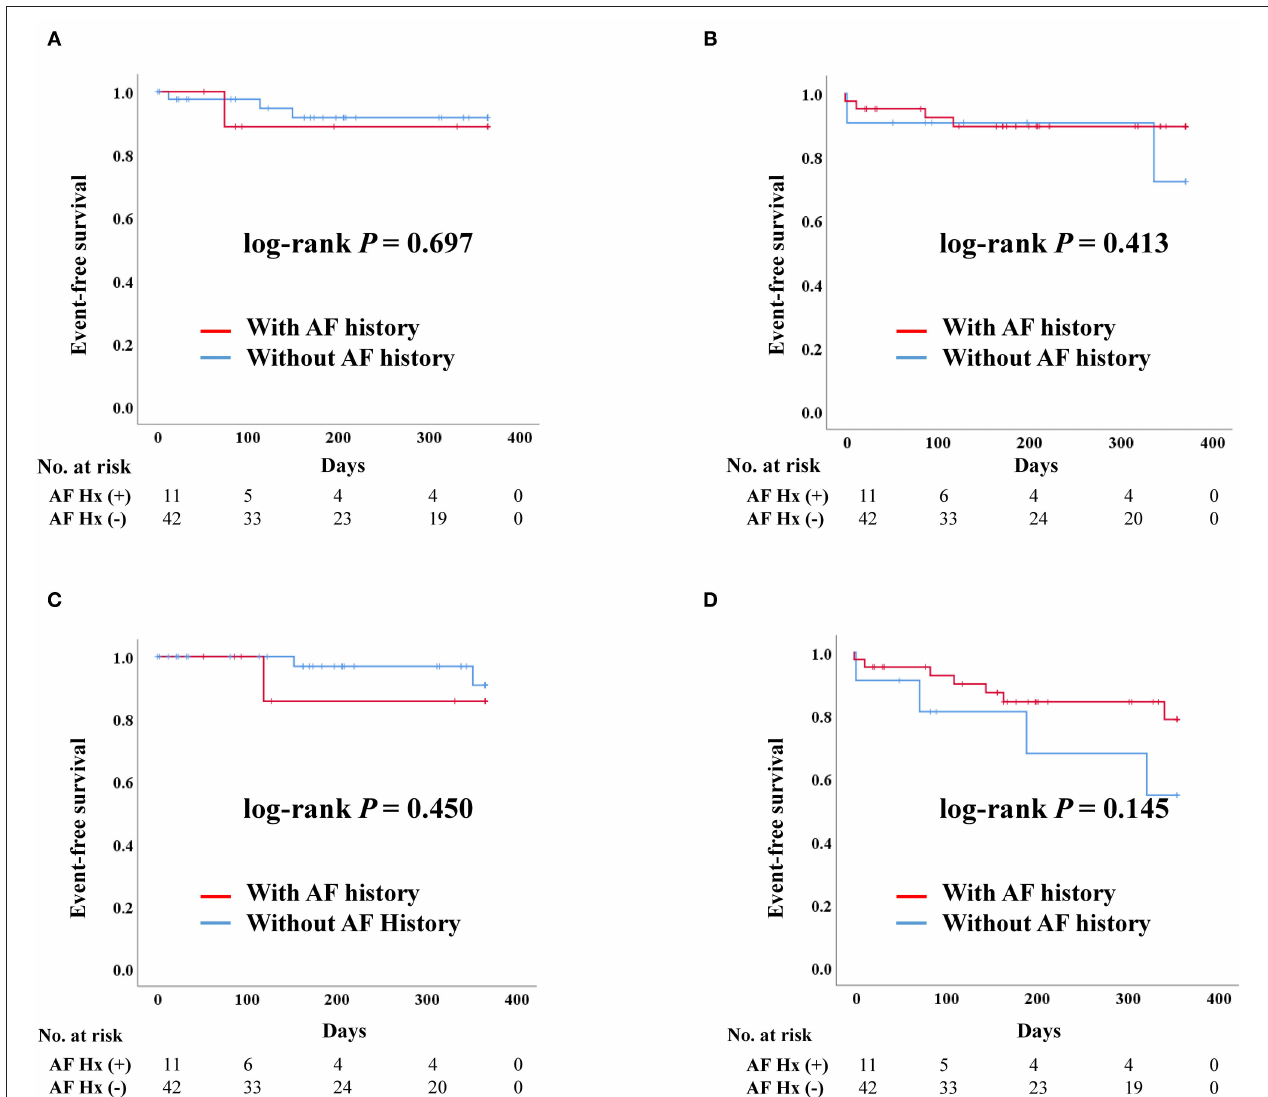
FIGURE 2 | Clinical outcomes of transcatheter aortic valve replacement (TAVR) according to previous history of atrial fibrillation after propensity score matching. AF, Atrial fibrillation; Hx, History; Composite outcome, Composition of admission due to heart failure, stroke, or death. (A) Admission due to heart failure. (B) Death. (C) Stroke. (D) Composite